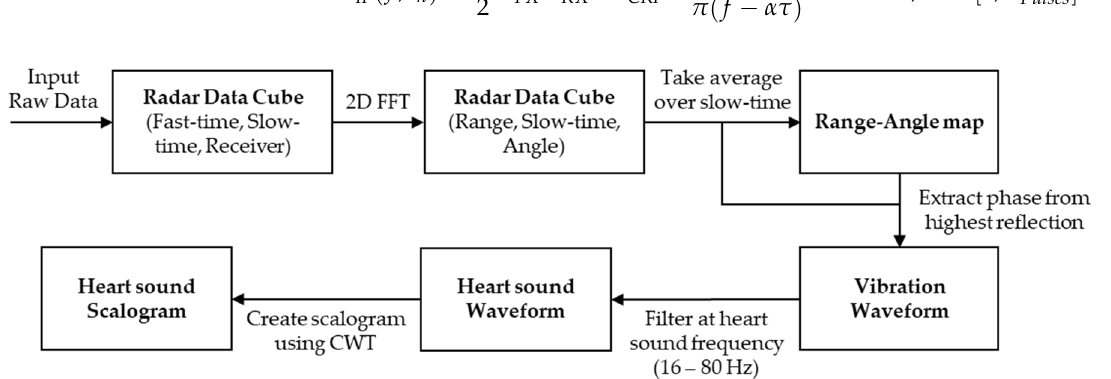
Figure 2. The signal processing pipeline for the heart sound biometric showing the major steps followed to extract the heart sound waveform and to convert it to an image (scalogram).